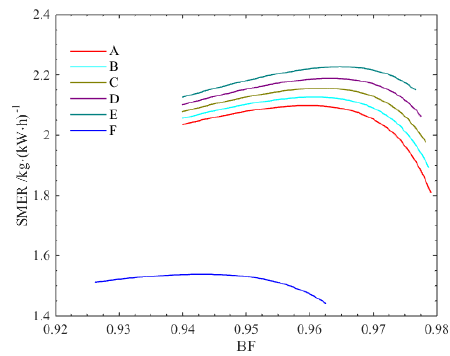
Figure 12. The e ff ect of the bypass factor (BF) on specific moisture extraction rates